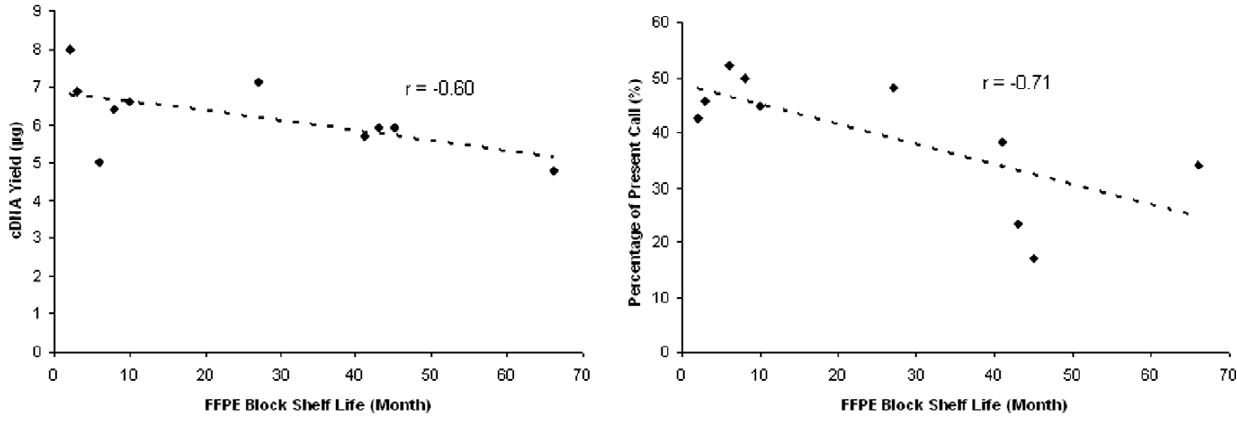
Figure 2. Correlations of FFPE block shelf life with cDNA yield and gene present call. Both cDNA yield and gene present call are negative correlated with FFPE block shelf life, with r= 2 0.60 and 2 0.71, respectively. Regression lines are represented as dot